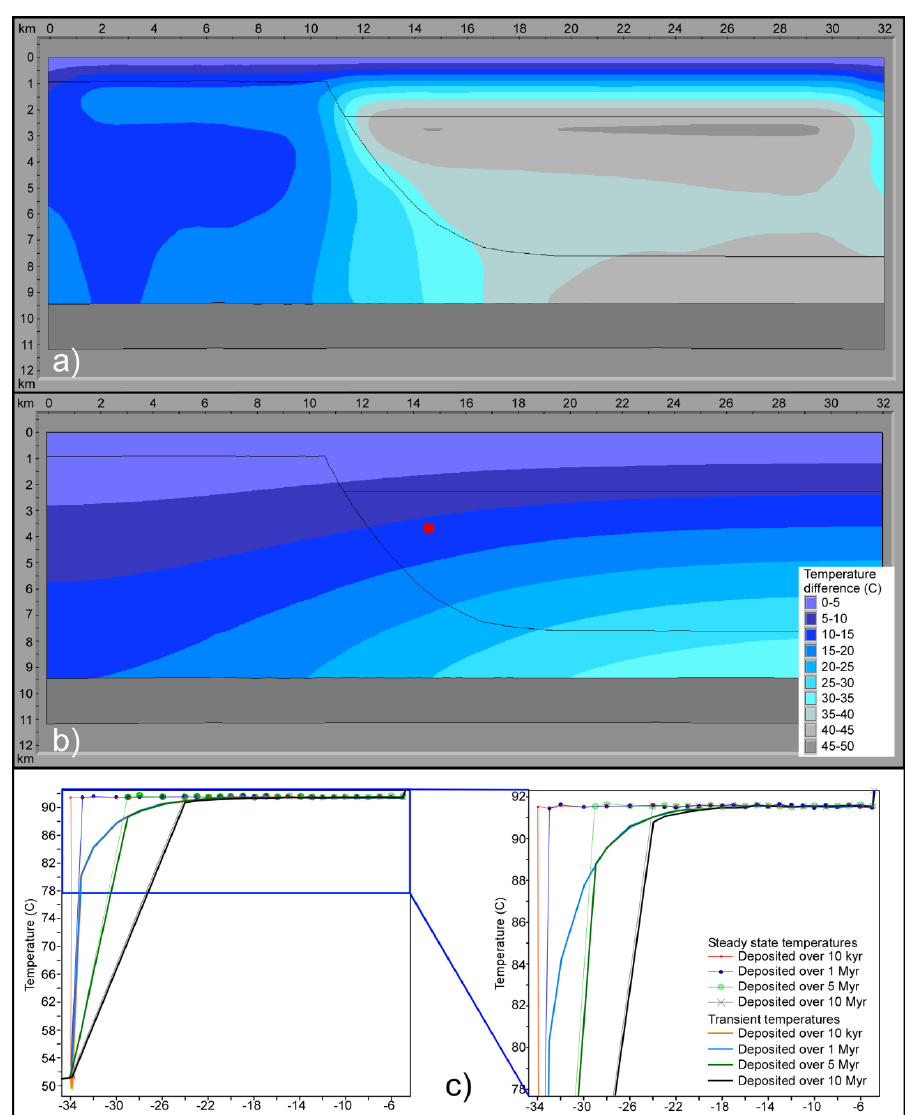
Figure 8. ( a ) Temperature difference between steady state and transient temperatures with fault slip and deposition over 10 kyr. ( b ) Temperature difference between steady state and transient temperature with fault slip and deposition over 1 Myr. Temperatures in ( a ) and ( b ) are from the same timestep, 10 kyr and 1.01 Myr respectively after faulting started. The red point in ( b ) indicates location of point plot in ( c ). ( c ) Resulting temperatures for four tested time spans of deposition of syn- and post-rift